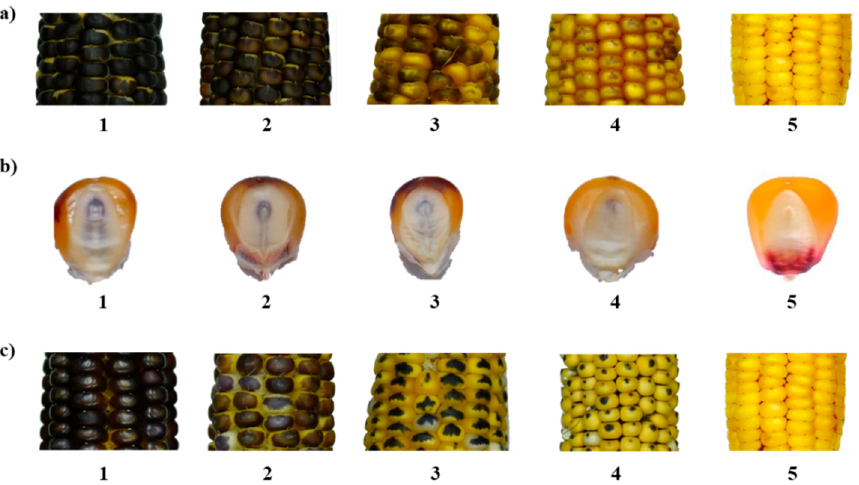
Figure 4. Variation in R1-nj anthocyanin expressions of dried seeds of putative haploid inducers. ( a ) Variation for intensity of purple coloration on the endosperm. ( b ) Variation for intensity of purple coloration on the embryo. ( c ) Variation for area marked of endosperm purple coloration.